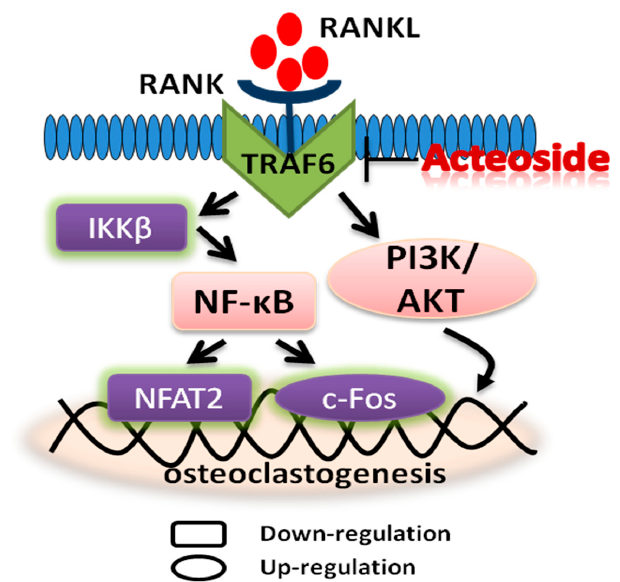
Figure 7. An overall hypothesis of the molecular mechanism: Acteoside could prevent bone loss on OVX mice through RANKL/RANK/TRAF6-mediated NF- κ B inactivation and PI3K/AKT stimulation, which is shown by the protein levels of TRAF6, RANKL, RANK, NF- κ B, IKK β , and NFAT2 being down-regulated, while the expressions of PI3K, AKT, and c-Fos were up-regulated as compared to the control.